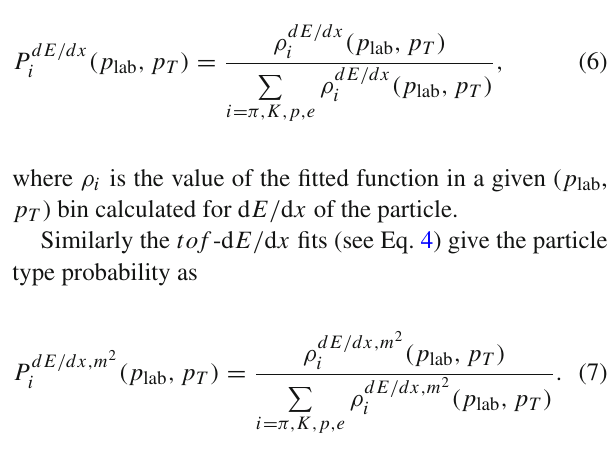
Fig. 11 Particle number distribution in the m 2 -d E / d x plane for negatively ( left ) and positively ( right ) charged particles with momenta 3 < p lab < 4 GeV / c and 0.3 < p T < 0.4 GeV / c ) for PSD selected Be+Be collisions at 40 A GeV /